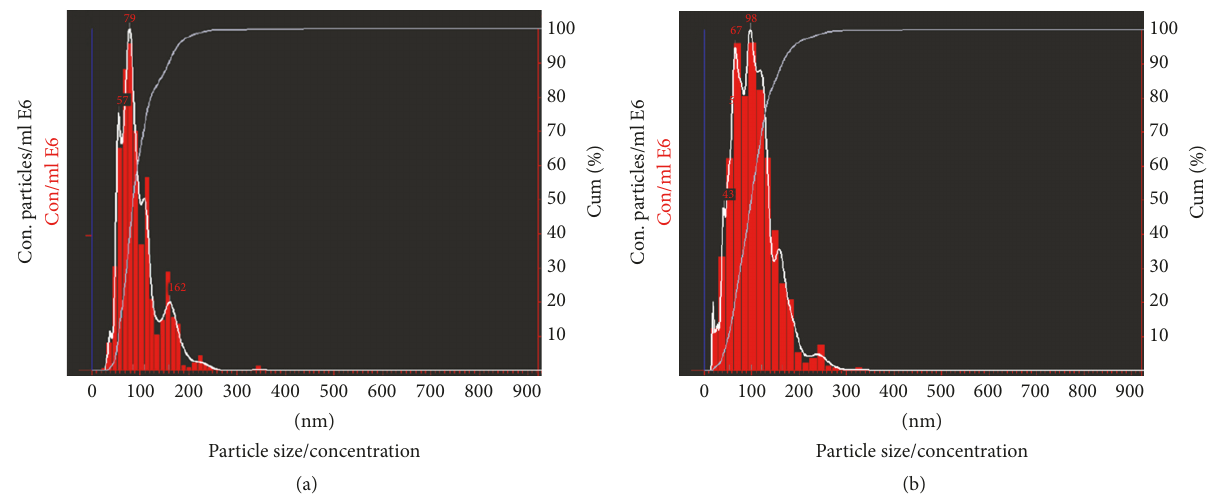
Figure 11: Concentration and size distribution from NTA measurements of CoNPs (8 :1) (a) and CoNPs (12:1) (b) in aqueous solution.